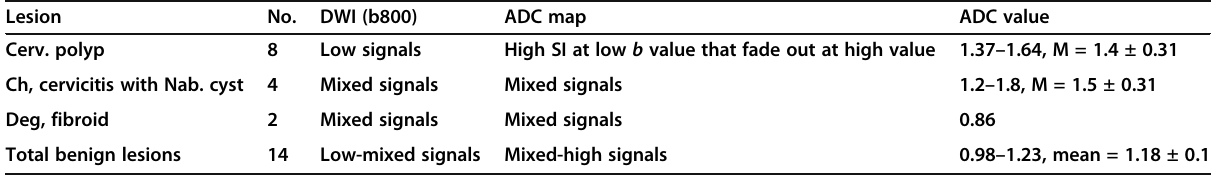
Table 4 DWI and ADC map findings in 14 benign uterine cervix focal lesions (group II) Lesion No. DWI (b800) ADC map Cerv. polyp Ch, cervicitis with Nab. cyst